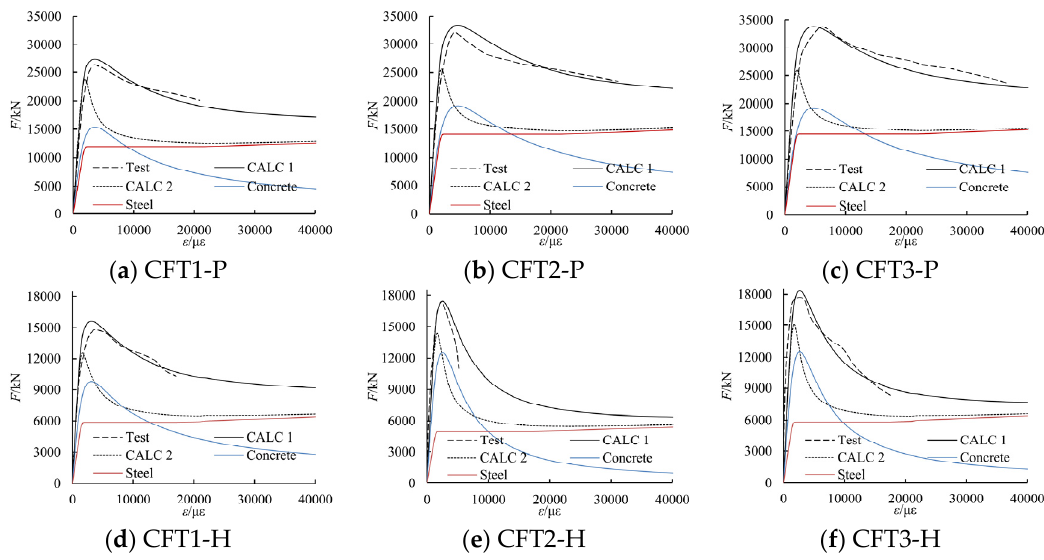
Figure 17. The estimated curves of load ‐ longitudinal strain relationship.